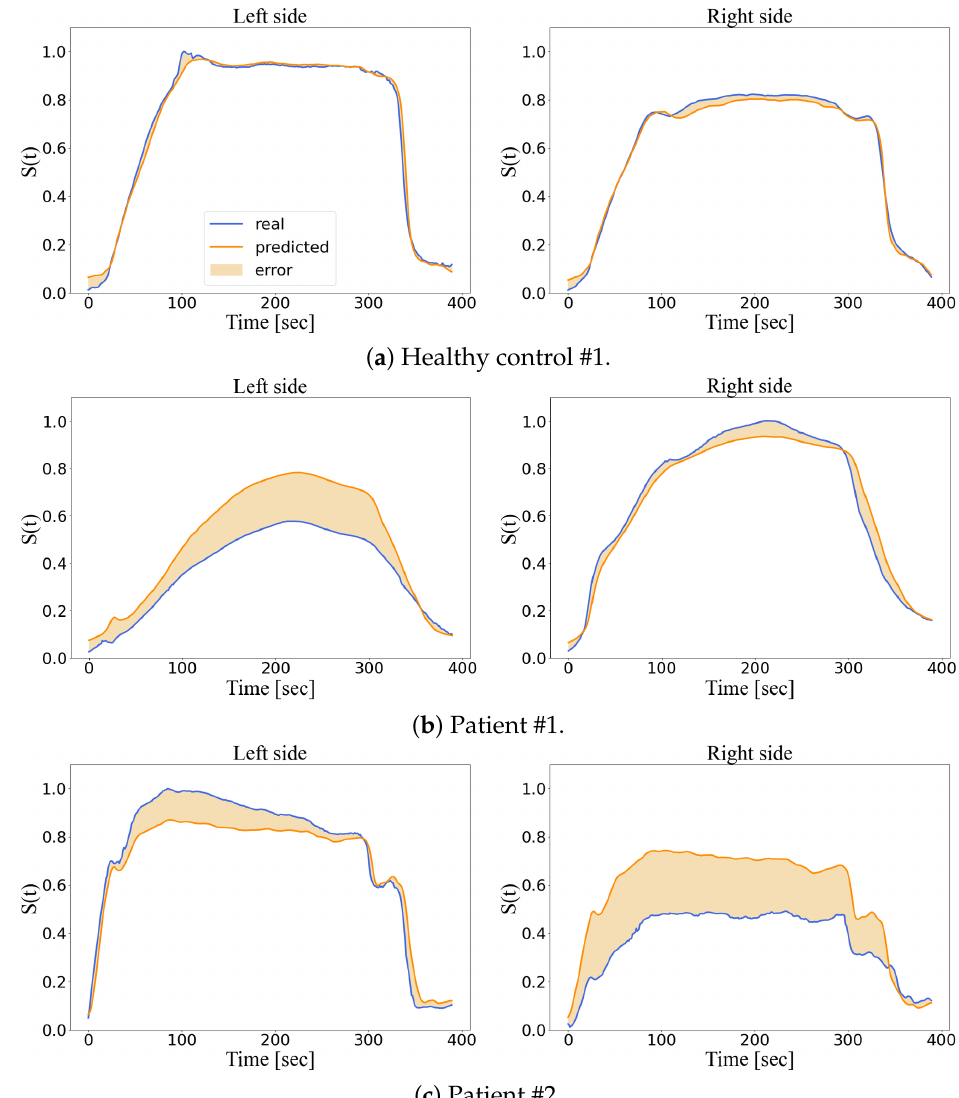
Figure 6. LSTM assessment of a relevant pair of distal markers on the test